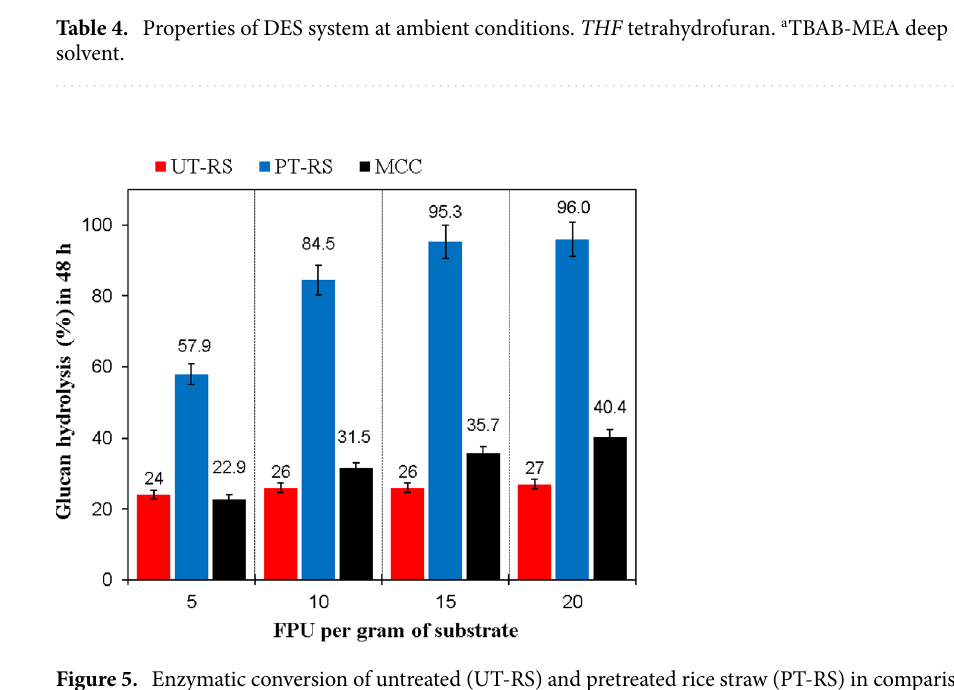
Figure 5. Enzymatic conversion of untreated (UT-RS) and pretreated rice straw (PT-RS) in comparison with MCC (control) at different cellulase dosages incubated at 50 °C for 48